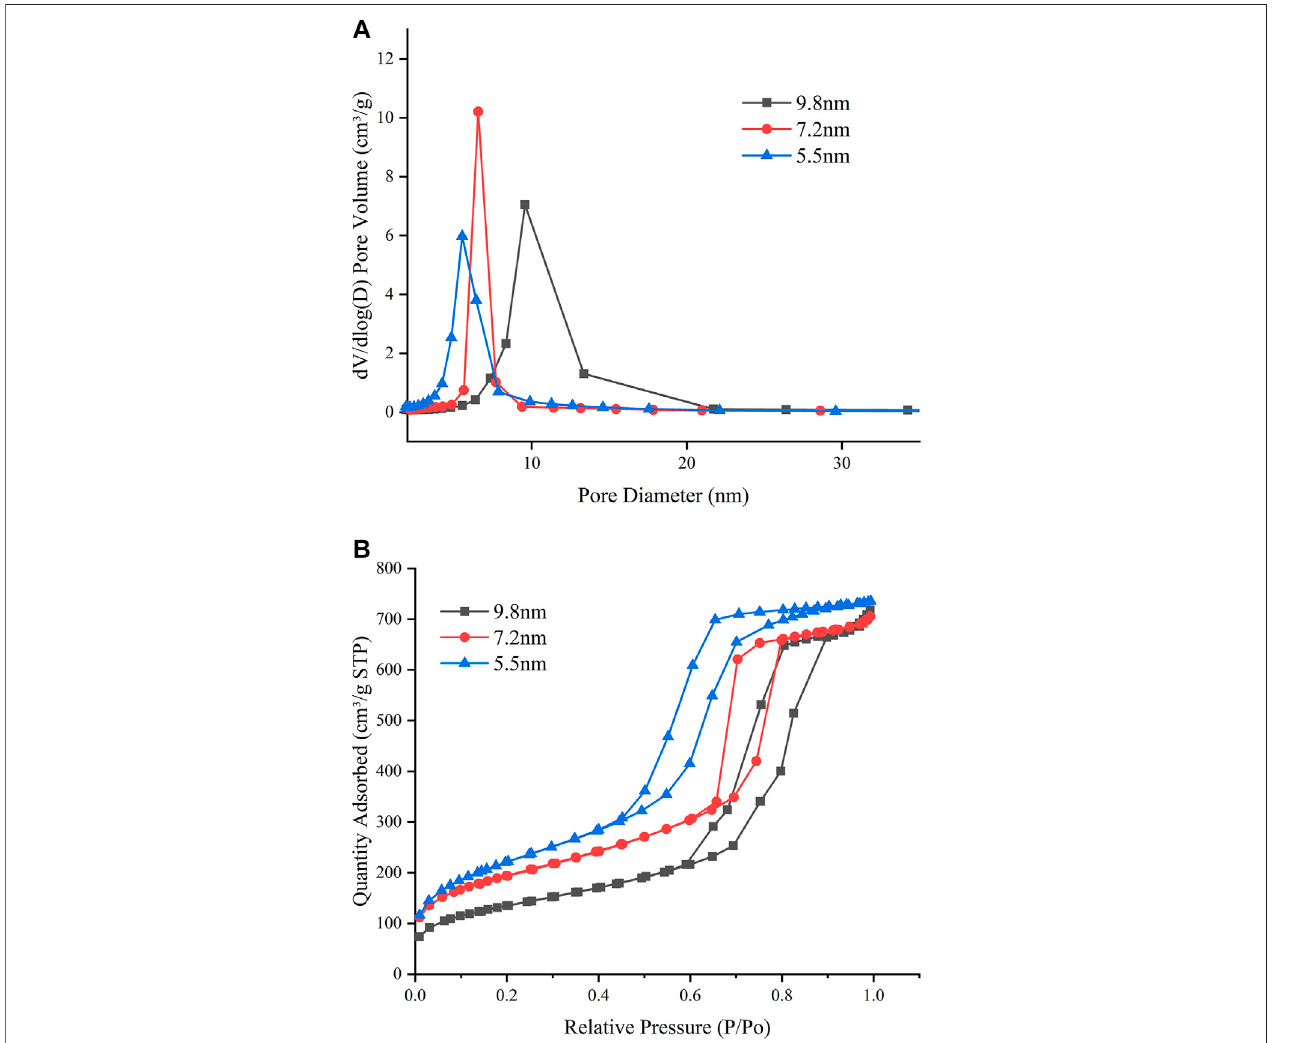
FIGURE 1 | (A) BJH pore-size distributions. (B) Nitrogen adsorption-desorption isotherms.